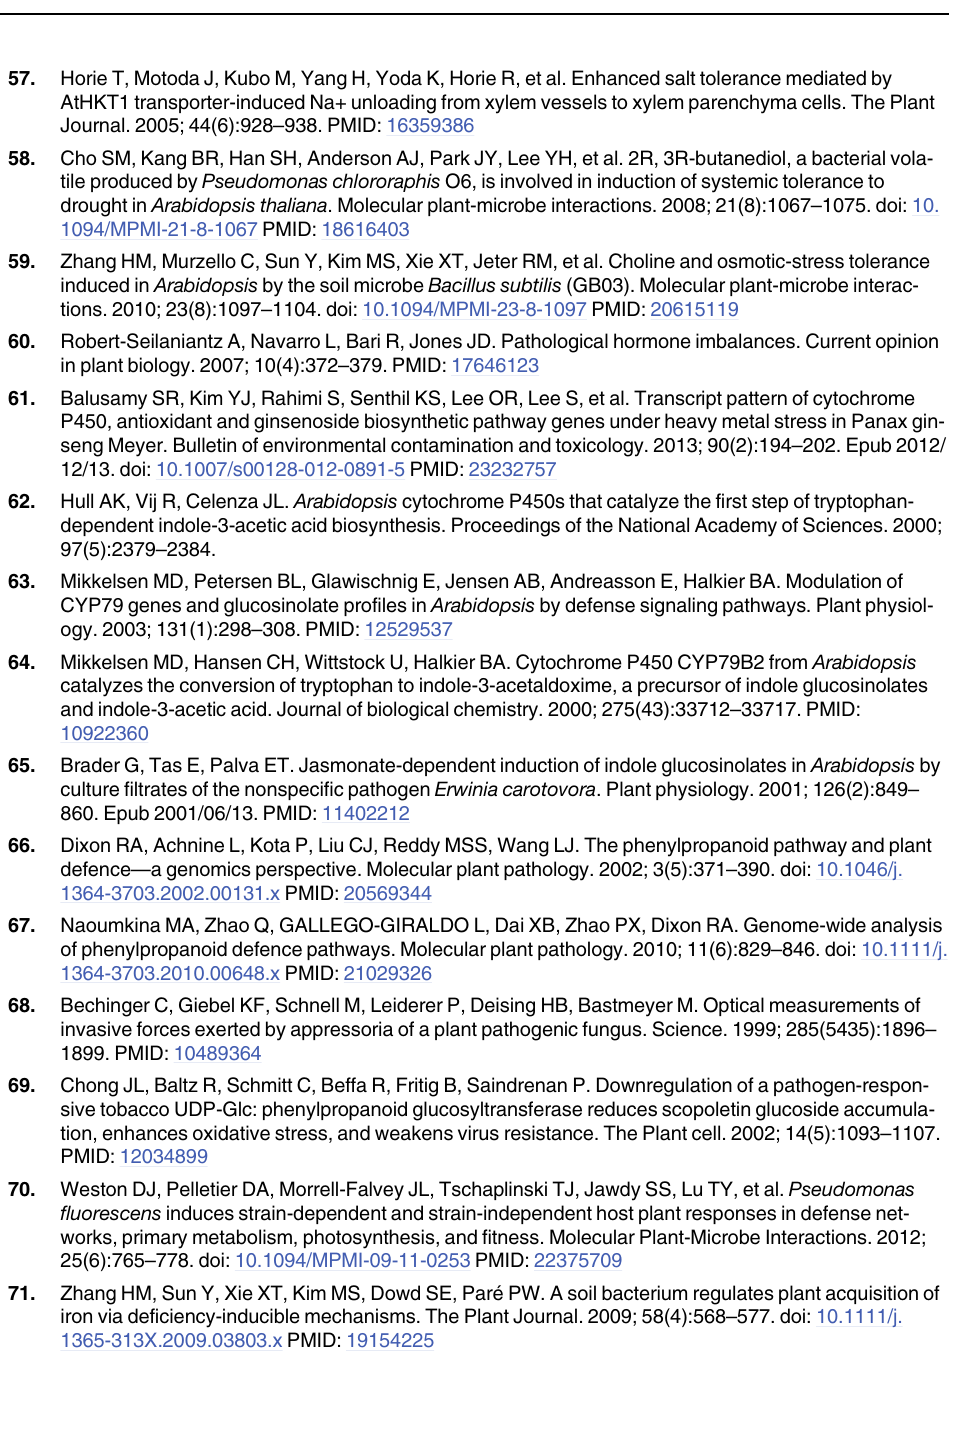
PLOS ONE | DOI:10.1371/journal.pone.0158621 August 11,